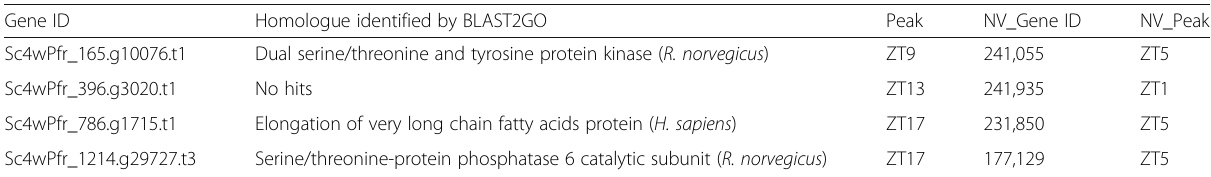
Table 5 Homologous diel cycle genes present in both Hydra vulgaris and Nematostella vectensis but not in Acropora millepora Gene ID Homologue identified by